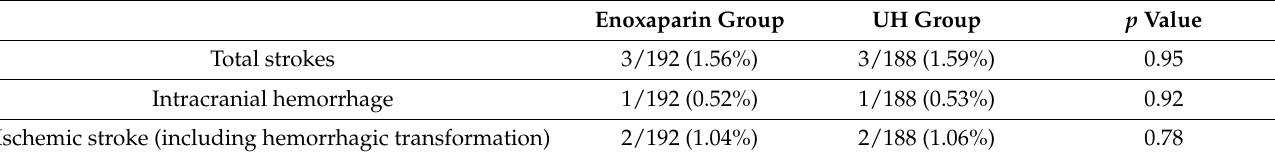
Table 6. In-hospital stroke